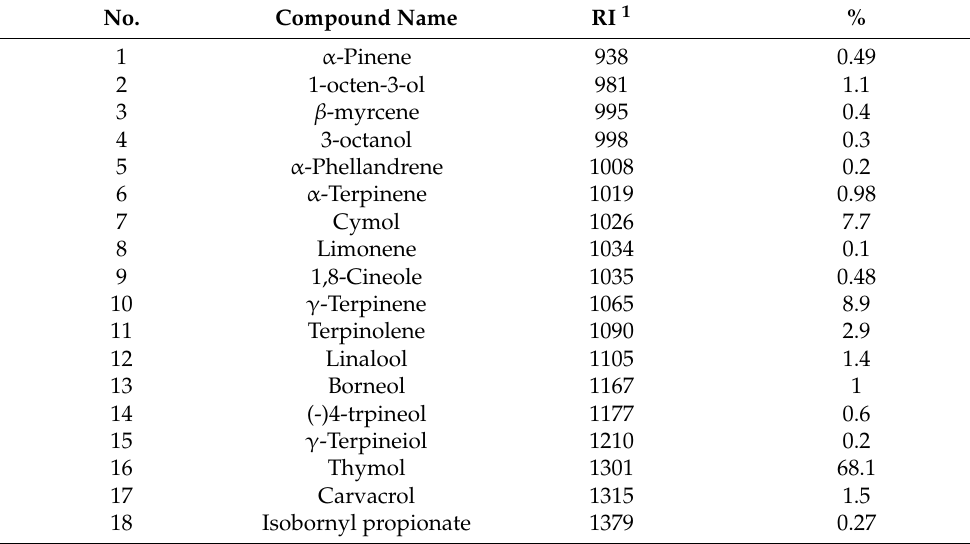
Table 2. Chemical composition of thyme essential oil (TEO) analysed by GC/MS.